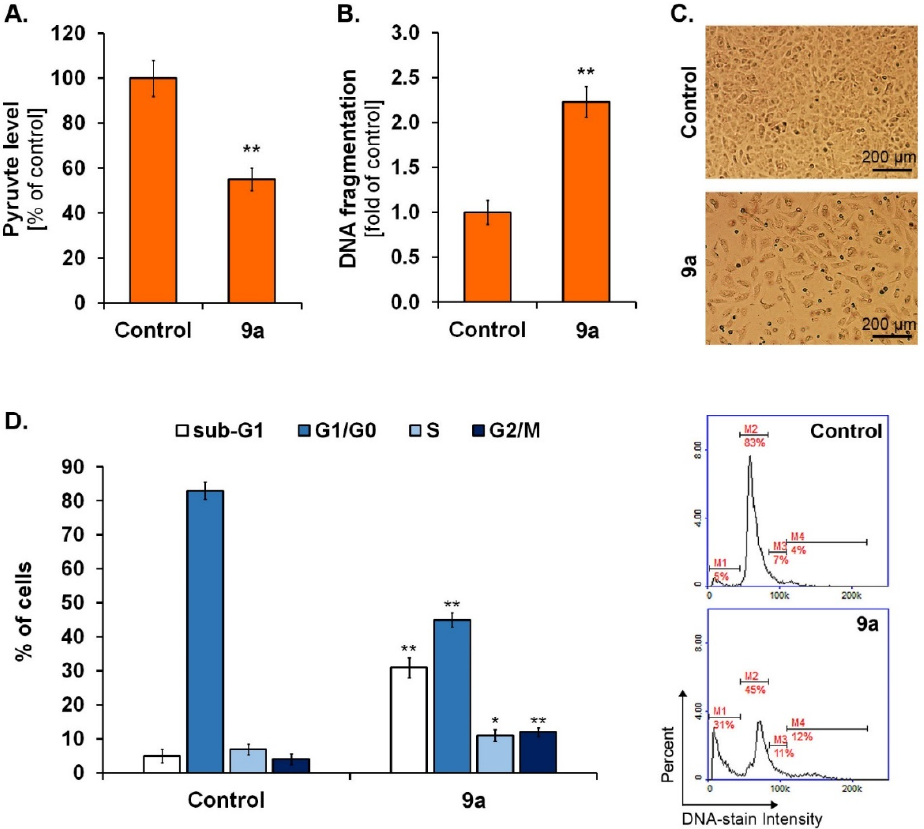
Figure 9. Multidirectional in vitro analysis of A549 cells response to compound 9a . The effect of 72 h treatment with the compound (200 µ g/mL) on an intracellular pyruvate level ( A ); bar graphs represent mean values ± SD of three independent experiments, ** p < 0.005 vs control (unpaired t-test). DNA fragmentation in A549 cells treated with compound 9a . Bar graphs represent mean values ± SD of three independent experiments, ** p < 0.005 vs control (unpaired t-test) ( B ); representative micrographs ( C ) of A549 cells cultured in T-75 flasks and observed using light-inverted microscope Eclipse TS-100-F (Nikon, Japan). Cell cycle phase distribution of control and 9a -treated A549 cells ( D ); bar graphs represent mean values ± SD of three independent experiments, * p < 0.05, ** p < 0.005 vs control (unpaired t-test); representative histograms: M1—cells in sub-G1 phase, M2—cells in G1/G0 phase, M3—cells in S phase, M4—cells in G2/M